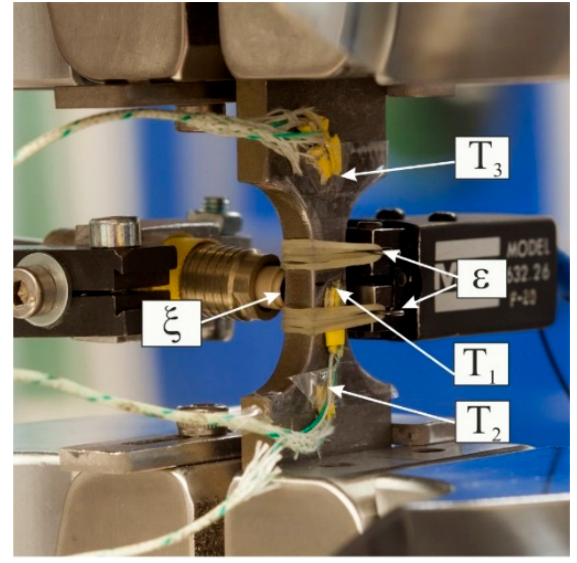
Figure 1. Experimental setup for fatigue testing with extensometer ( ε ), Feritscope ® ( ξ ) and thermocouples ( T 1 – T 3 ).